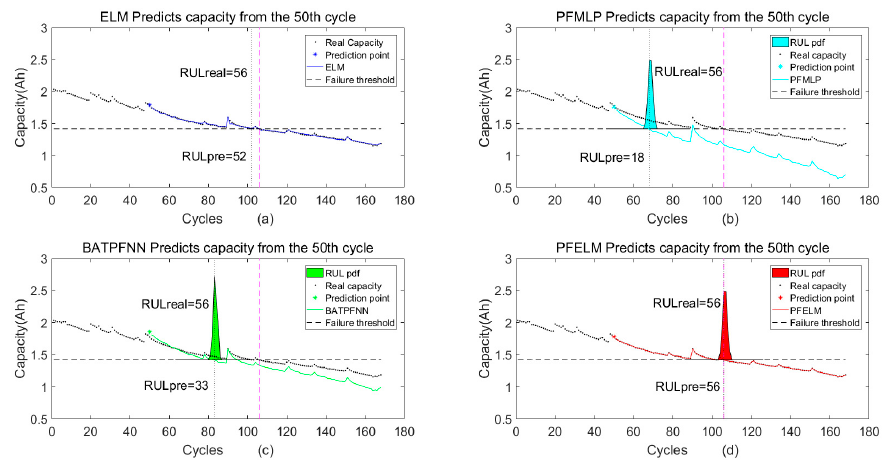
Figure 12. Predicting capacity from the 50th cycle by different algorithms: ( a ) ELM ; ( b ) PFMLP; ( c ) BATPFNN; ( d ) PFELM.